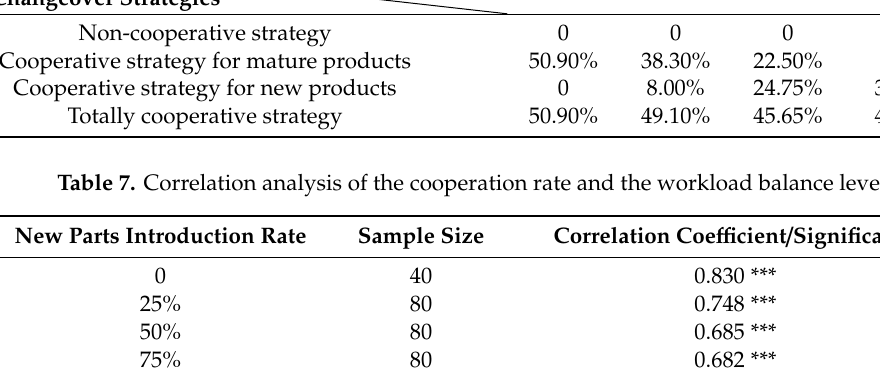
Table 6. Average cooperation rates of changeover tasks under different conditions. Changeover Strategies